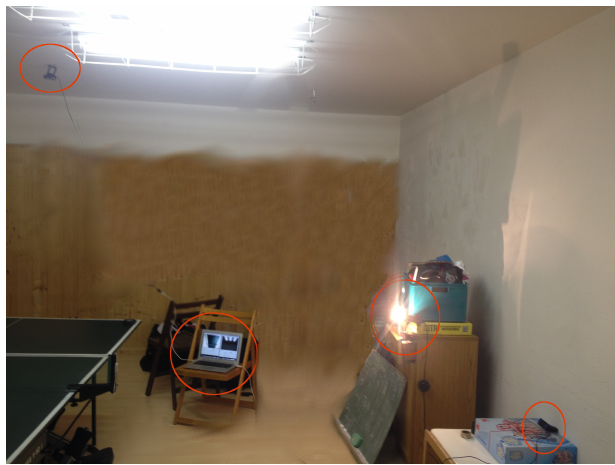
Figure 2. Red marked are both of the cameras as well as the computer and an additional light source Due to the fact that the implemented ball detection is based on color, we used an orange ball which is an official competition ball and easier to detect with most backgrounds than white ones, especially with respect to contrast (Figure 3).